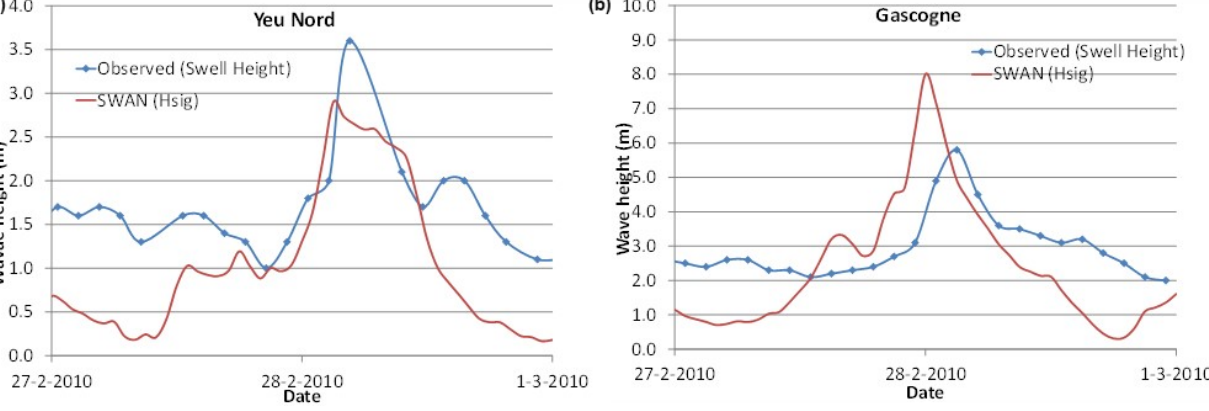
Figure 5. Deep water buoys of Yeu Nord (a) and Gascogne (b) . In the first case the buoy is located close by an island of the same name. The second is located in the open ocean almost in the middle of the Bay of